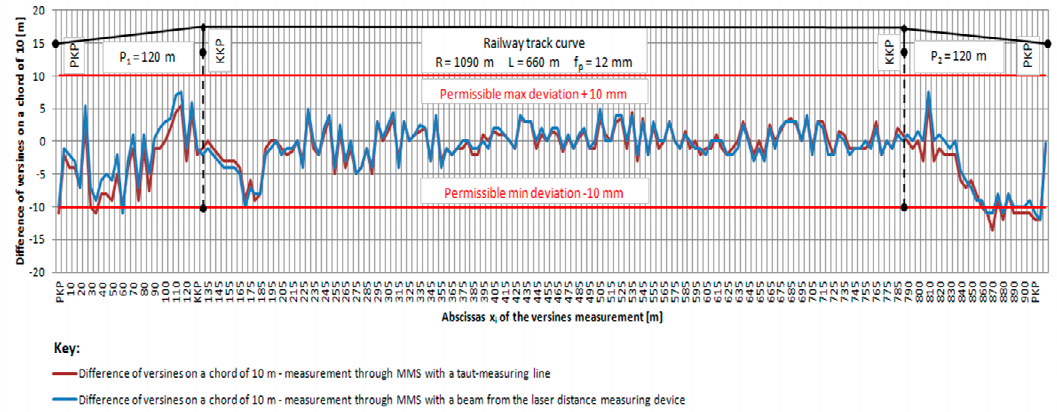
Figure 9. A diagram with differences of horizontal versines on the basis of the measurement chord c i = 10 m (own Figure).